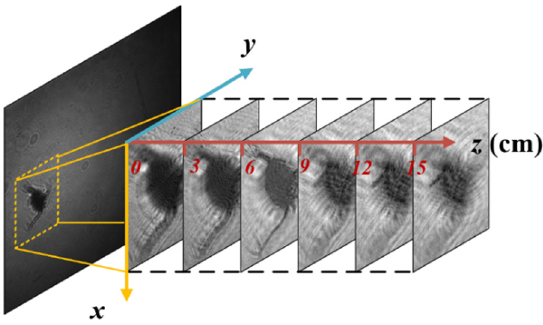
Figure 6. The reconstructed image in different cross-sections in the sampling volume using ASM.